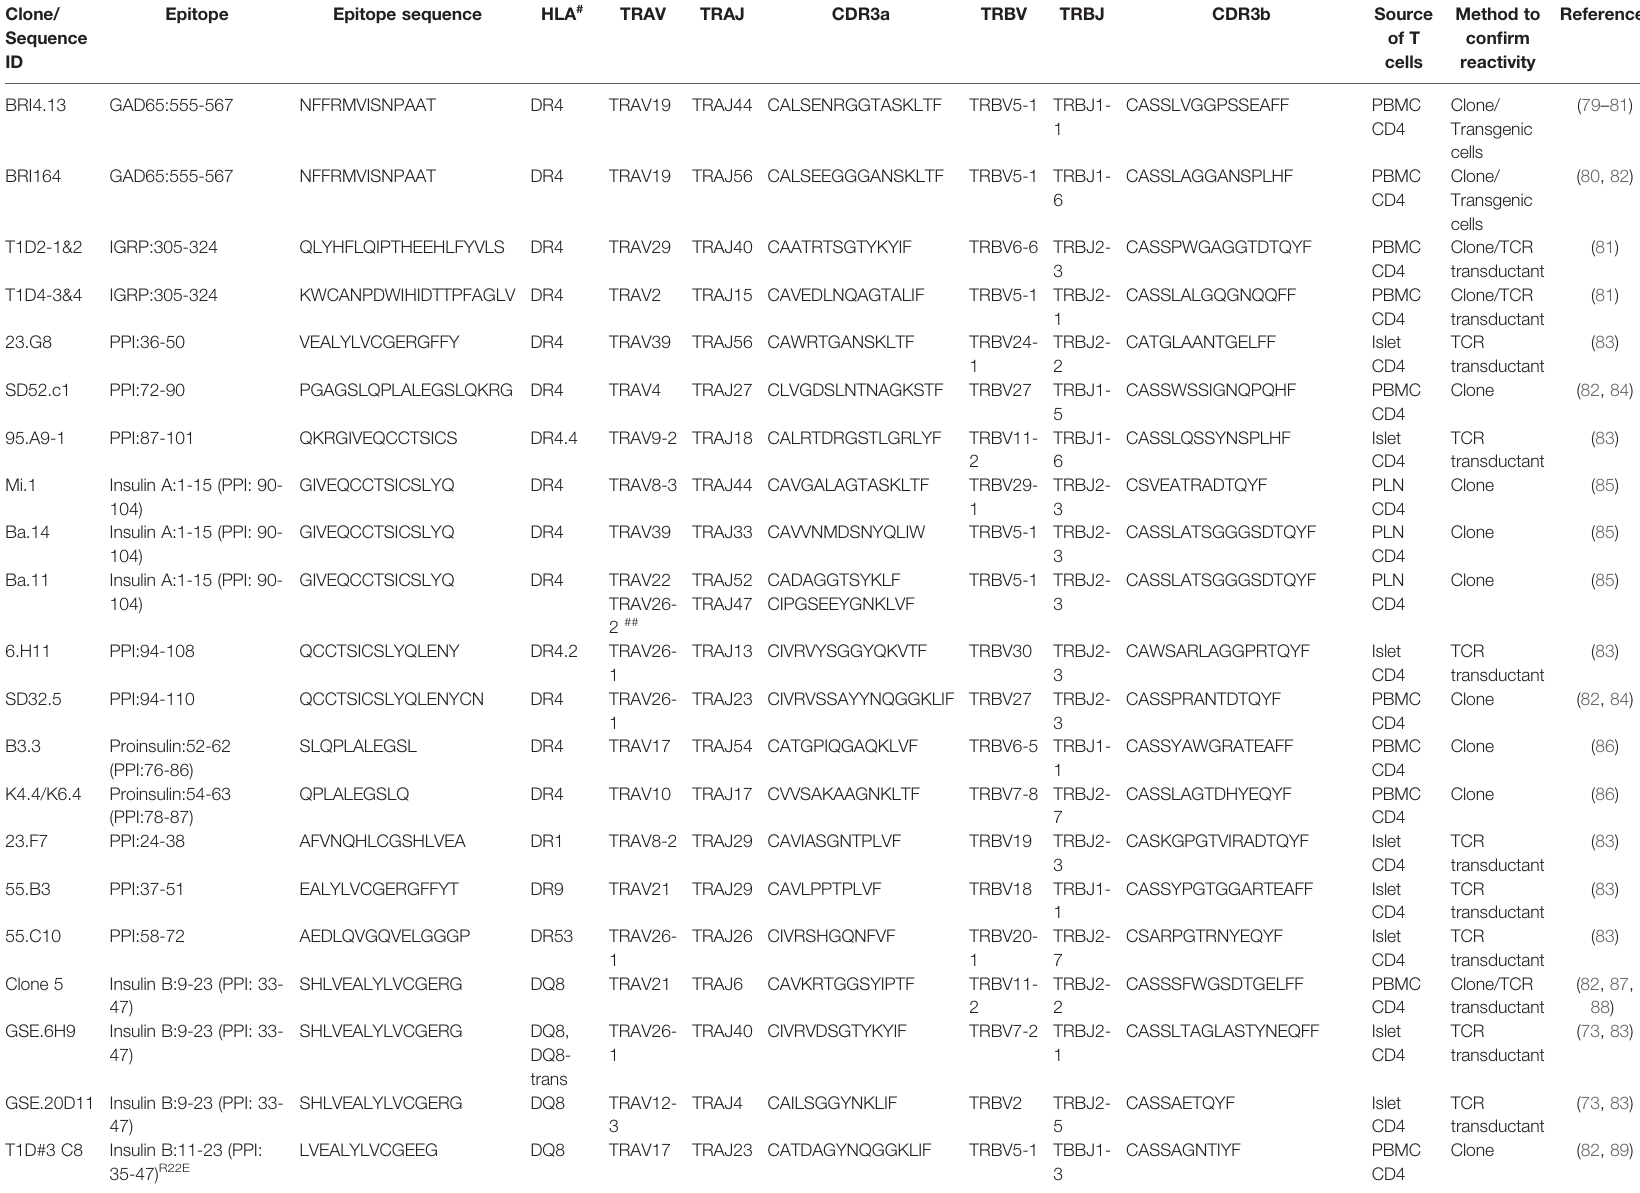
TABLE 2 | T cell receptors speci fi c to islet epitopes. Clone/